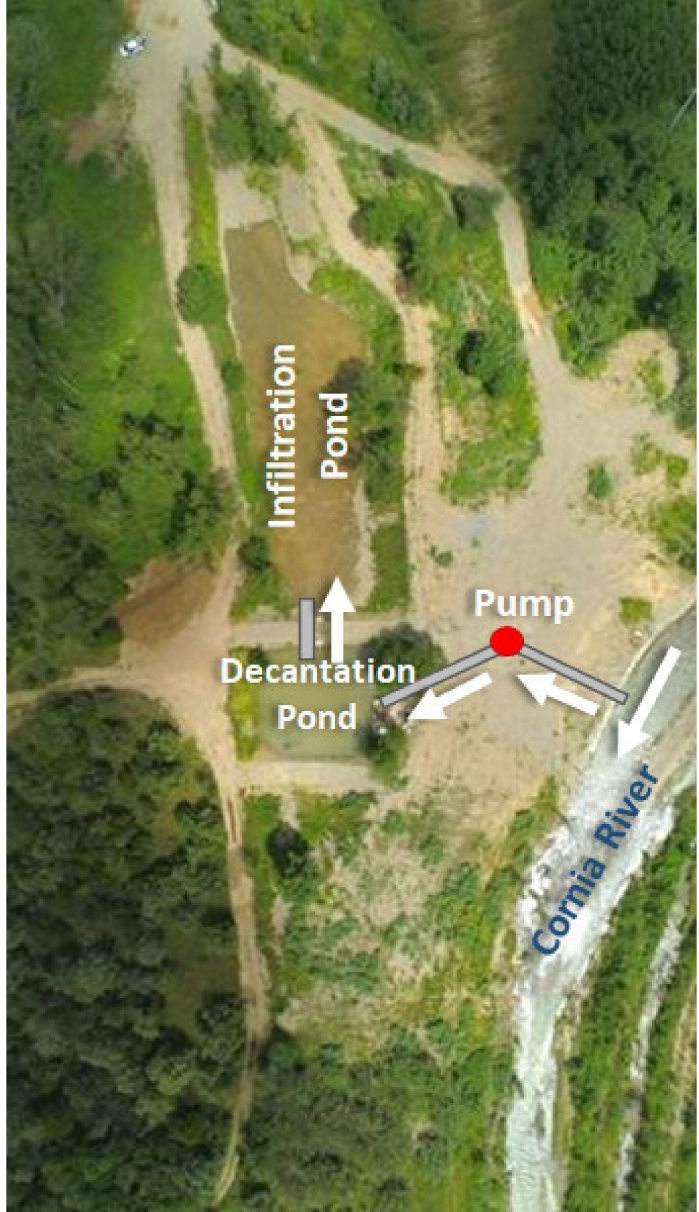
Figure 4. LIFE REWAT Managed Aquifer Recharge